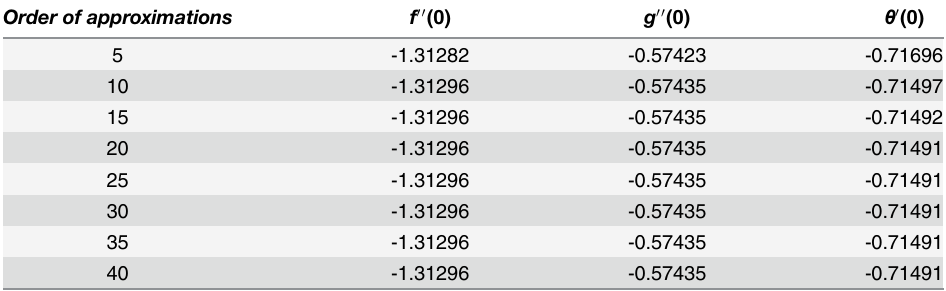
Table 1. Convergence of HAM solutions for different orders of approximations when β = γ = 0.25, Pr = 1, M = λ = 0.5 and ℏ = − 0.8.